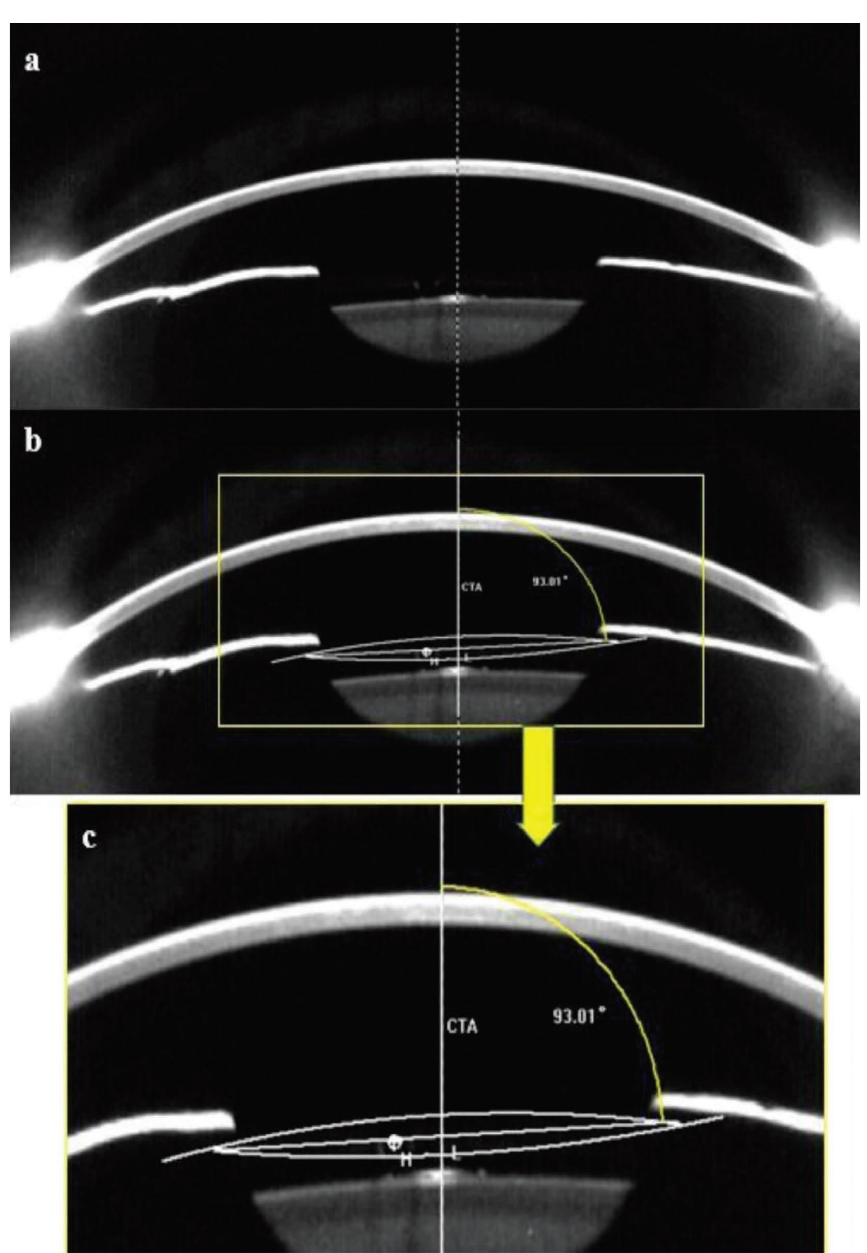
Figure 2: Te anterior segment pentacam image with the ICL horizontal. (a) Te white point H on the processed image (b) indicates the ICL central hole, while line L represents the plane of the ICL; the ICL axis runs perpendicular to the ICL plane. (c) Te ICL tilt degree (between the CTA and the ICL axis) is 93.01 ° –90 ° � 3.01 °